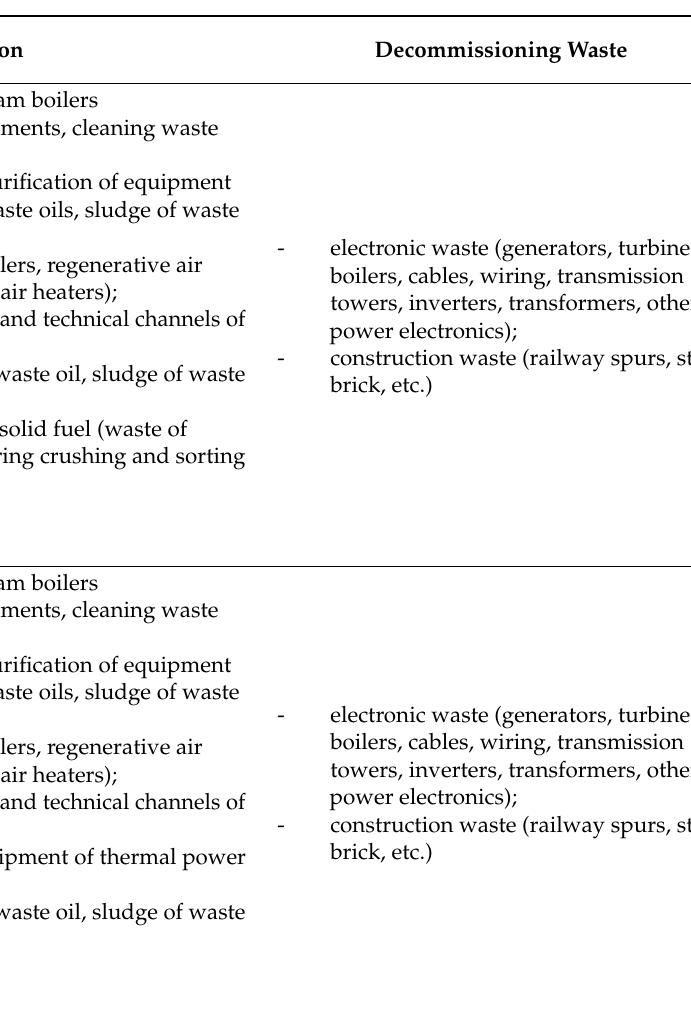
Table 2. Waste generated on energy enterprises (made by authors using data from